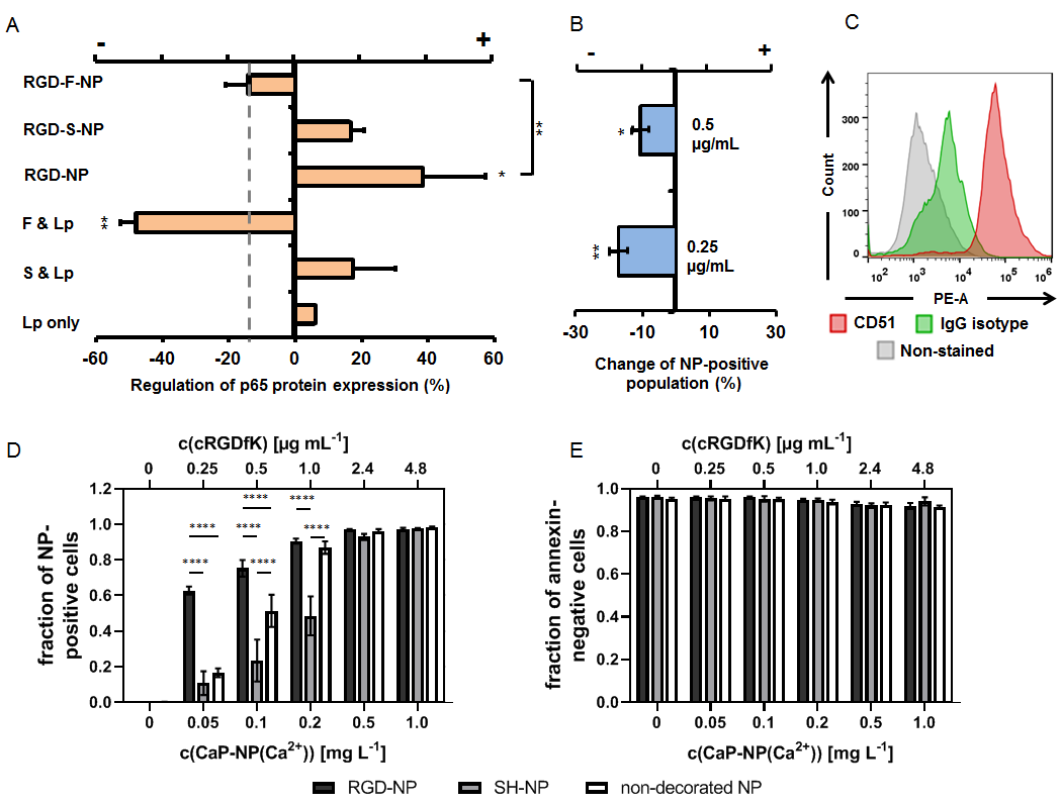
Figure 3. The potential of RGD-decorated CaP/PEI-Cy5/SiO 2 nanoparticles to down-regulate NF-kappa B p65 protein expression in murine endothelial cells (SVEC4-10). ( A ) Potential of nanoparticles to down-regulate p65 together with each of their components as determined via immunoblotting, nanoparticle concentration: 1 µg/mL siRNA. For detailed specification of nanoparticle formulations used see Table 1. F = functional siRNA, S = scrambled siRNA, Lp = Lipofectamine TM . The down-regulation is the ratio of the p65 expression with respect to the inflammatory condition (LPS-primed cells, absence of nanoparticles) set to zero. "+ regulation" = up-regulation; "- regulation" = down-regulation. The dashed line depicts the non-inflammatory condition. ( B ) RGD-specific-binding of the decorated nanoparticles as determined by flow cytometry (change of nanoparticle-positive cells under competition condition (non-competition condition = 0)). ( C ) Control for the expression of CD51 (integrin α V) on the endothelial cell surface as target molecule of RGD-NP determined via flow cytometry. ( D ) Nanoparticle uptake. ( E ) Nanoparticle biocompatibility (annexin-negative cells). Statistical differences between control or the indicated groups with * p < 0.05, ** p < 0.01, **** p < The impact of antibody-decorated and functional (p65 siRNAf) nanoparticles on T- and 351 B-cells 352 In T-cells, all IgG-decorated nanoparticles resulted in a down-regulation of p65 353 NF- κB protein expression with respect to non-nanoparticle exposed cells (stimulated 354 cells only, set to zero) independently of whether or not the siRNA was specific for p65 355 (siRNAf or siRNAs). Obviously, the combination of IgG and siRNA was favorable to down-regulate p65 NF- κB protein expression in those nanoparticle-exposed cells (Figure